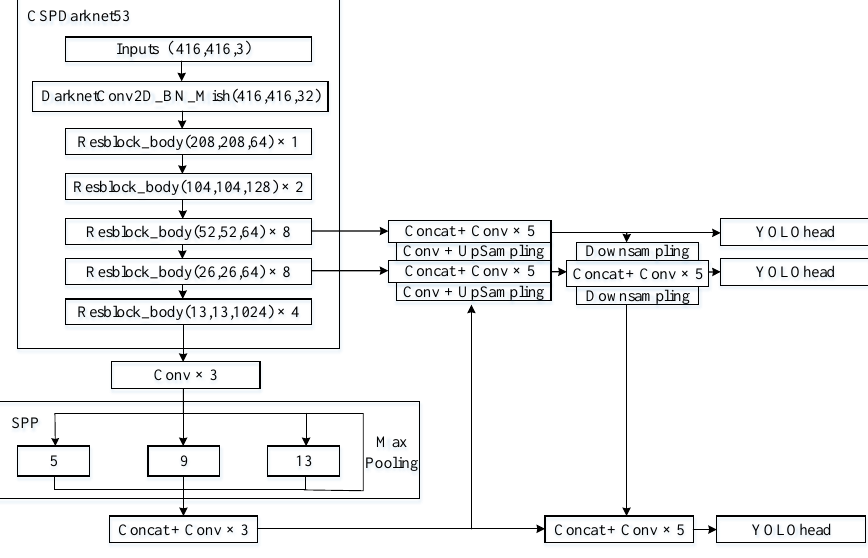
Figure 4. YOLOv4 network